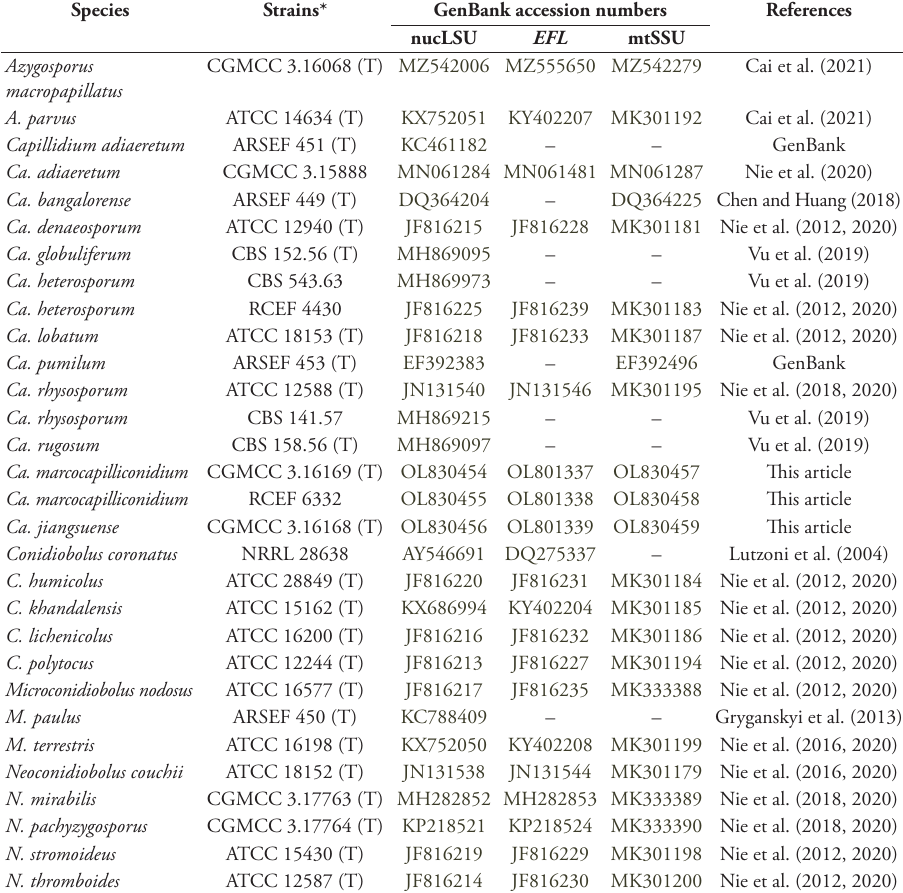
Table 1. The species used in phylogenetic